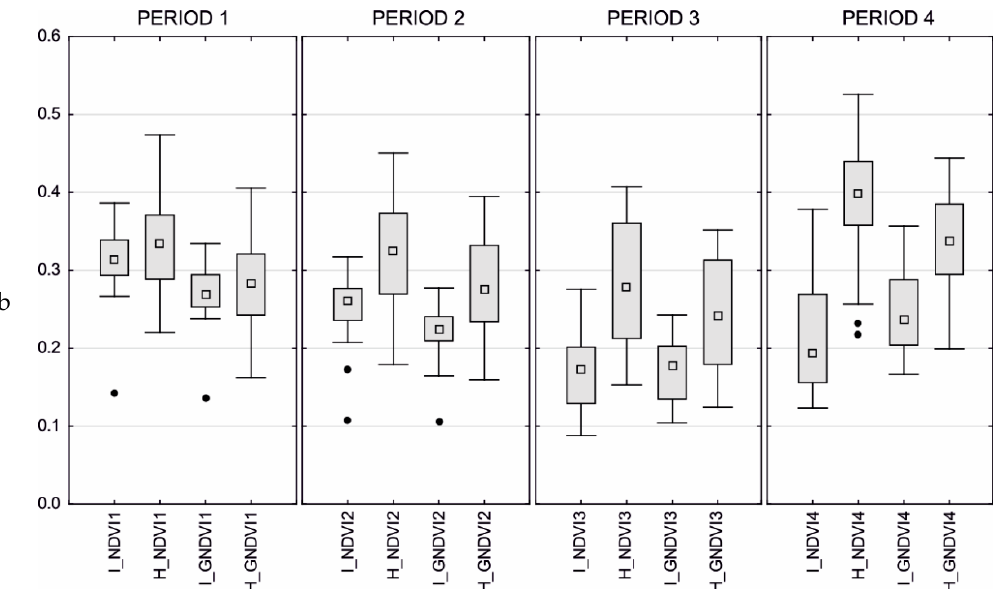
Figure 3. (a) Box-plots displaying quartile characteristics (median, Q25, Q75) for SR, GI, and GRVI, respectively (always in the order I-sample—infested, H-sample—healthy), in the four sensing periods. Black dots represent outliers; (b) Box-plots displaying quartile characteristics (median, Q25, Q75) for NDVI and GNDVI, respectively (always in the order I-sample—infested, H-sample—healthy), in the four sensing periods. Black dots represent outliers.